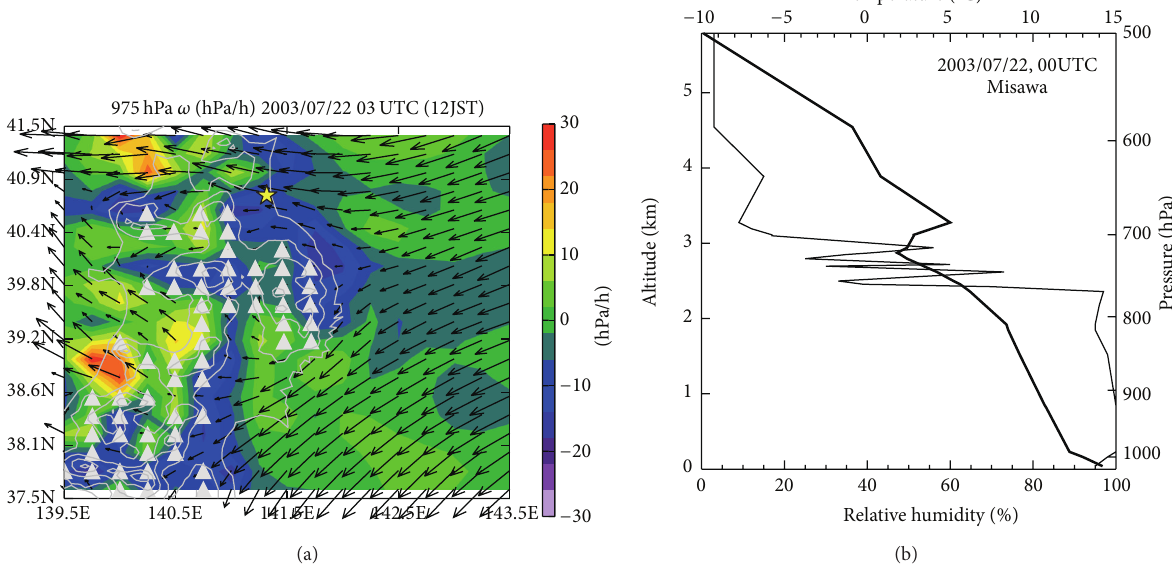
Figure2:(a)Mapofverticalwindvelocity( 𝜔 ,hPa/h,andcolorshading)andhorizontalwindvectorsat975 hPaat0000UTCJuly22,2003.The white contour lines on land show elevations (contour interval, 300 m); white triangles indicate the locations of mountains with equivalent heights greater than 975 hPa; latitude and longitude resolution, 0.5 degrees. The star shows the location of Misawa (141.38 ∘ E, 40.7 ∘ N). (b) Vertical profiles of temperature (K; thick lines) and relative humidity (%; thin lines) at Misawa at 0000 UTC July 22, 2003.